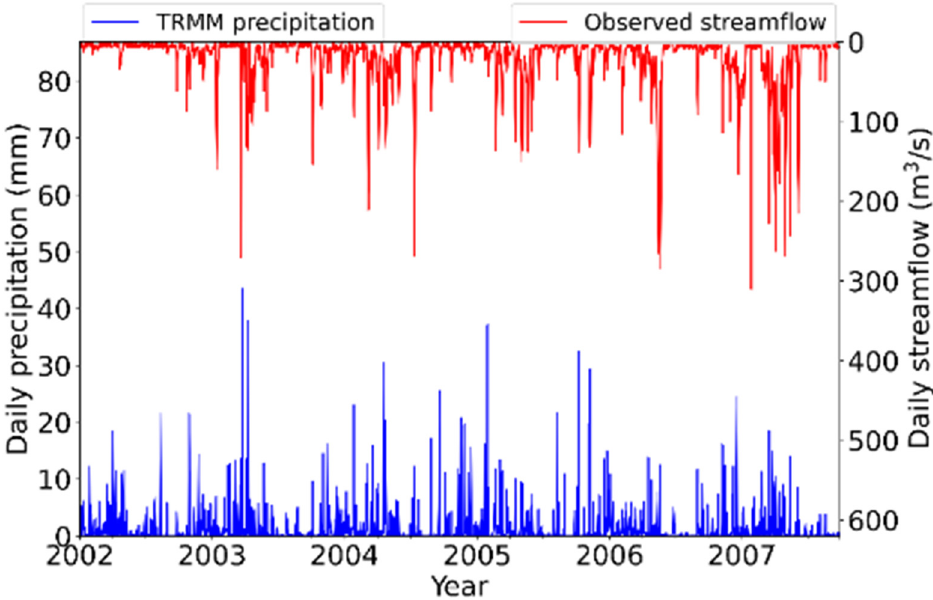
Figure 2. Measured discharge and mean TRMM satellite rainfall data from 2002 to 2007.